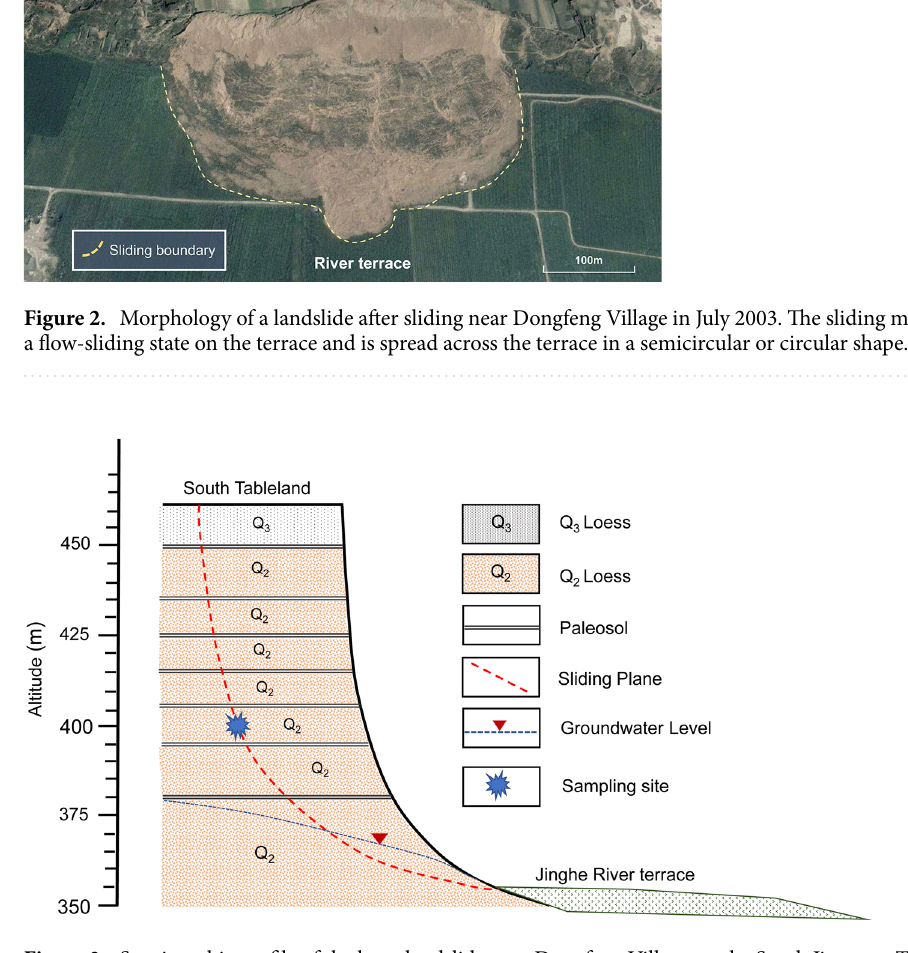
Figure 3. Stratigraphic profile of the loess landslide near Dongfeng Village on the South Jingyang